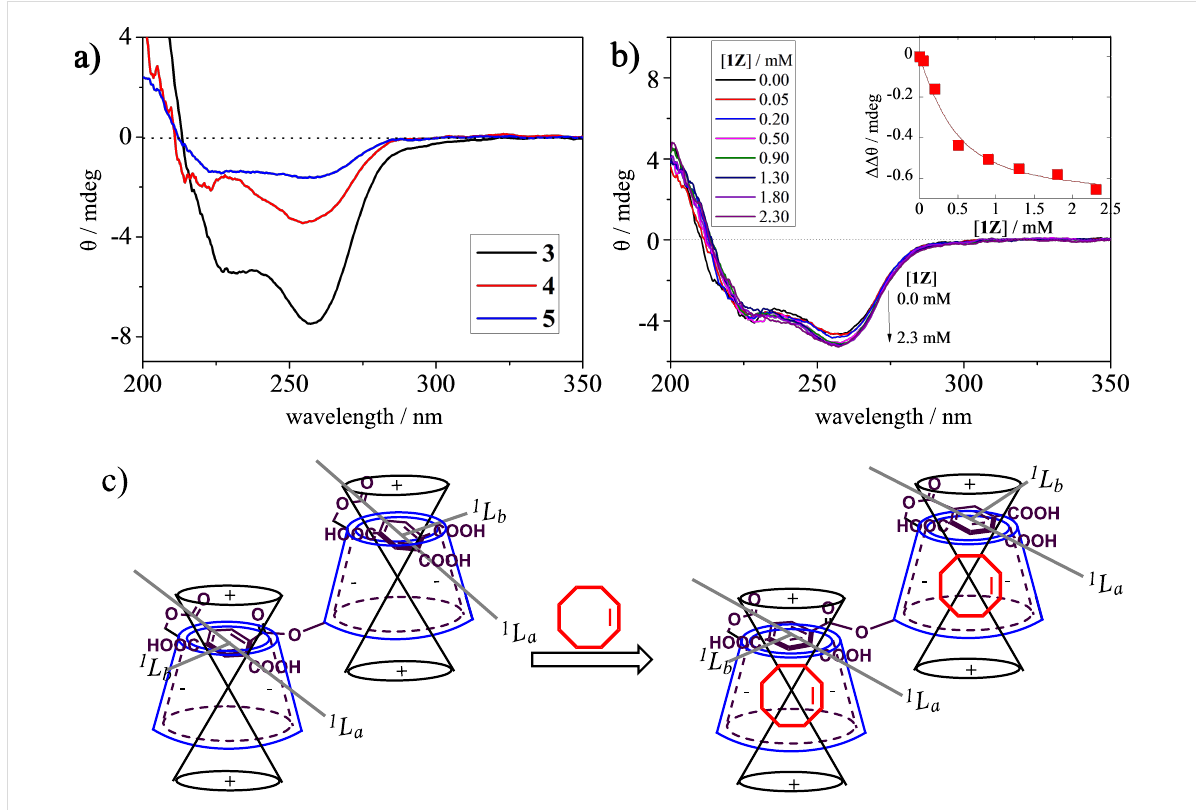
Figure 1: (a) Circular dichroism spectra of 3 (67 μ g/mL) (black), 4 (67 μ g/mL) (red) and 5 (50 μ g/mL) (blue) in pure water at 25 ºC, and (b) of 3 (560 μ g/mL) in the presence of 0–2.3 mM 1Z ; Inset shows the nonlinear least-squares curve fit of the ellipticity changes at 257 nm, assuming the 1:1 stoi- chiometry, from which the apparent binding constant was determined to be 4000 ± 1000 M − 1 . (c) Schematic illustrations of the conformational change of CDNS upon inclusion of 1Z .